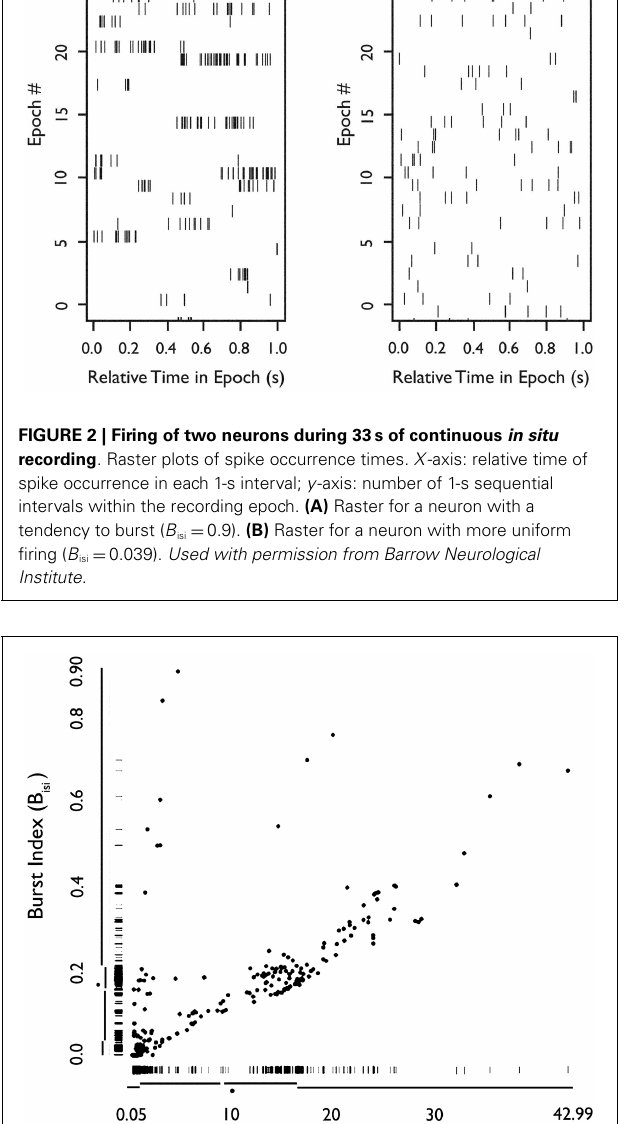
binomial test). Within this subgroup of 417 neuron pairs, 281 (67%) were positive peaks, indicating an increased level of firing together in